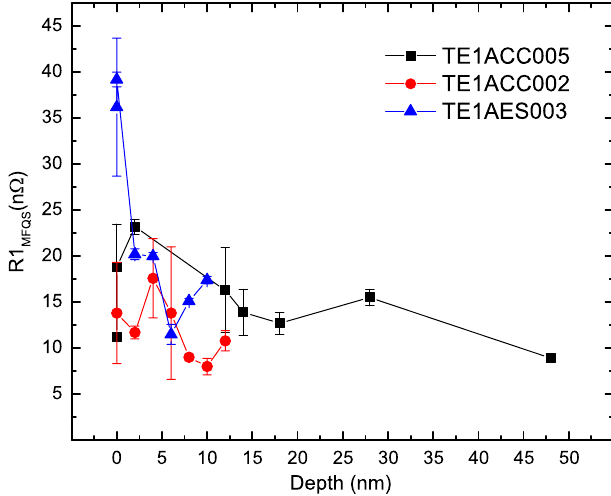
FIG. 8. MFQS fit results for the parameter R 1 with (cid:4) ¼ 0 for all fits as a function of material removal depth. Error bars describe standard errors of the